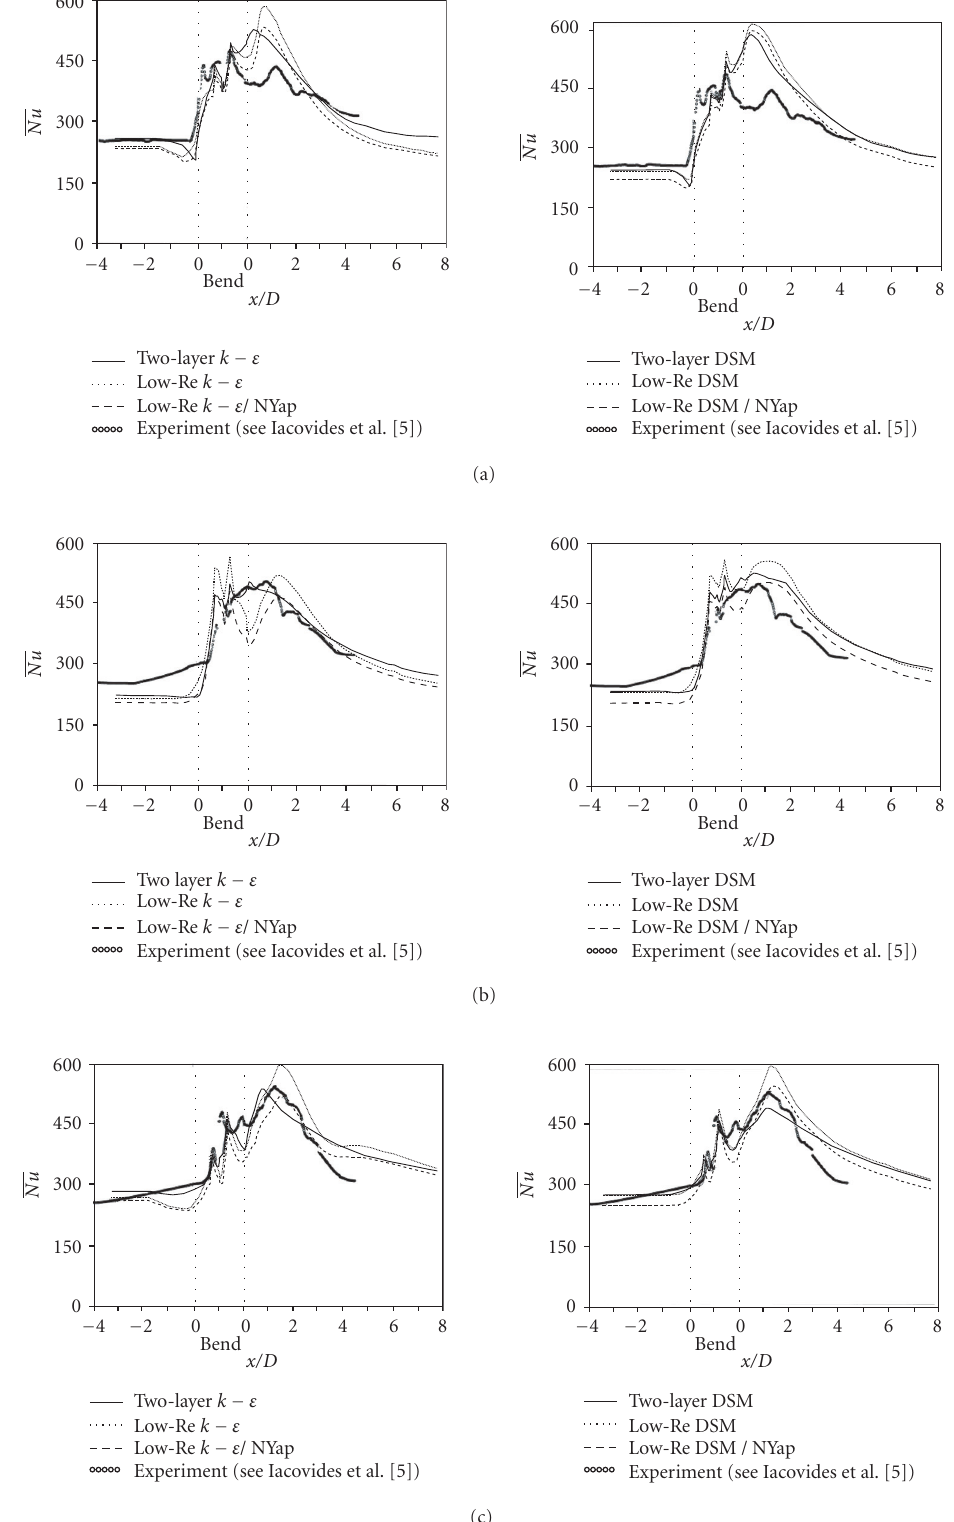
Figure 8: Comparisons of the axial variation of the side-averaged Nusselt number along the flat wall for the stationary and rotating cases. Re = 36000, Pr = 5 . 9, and Ro = 0 . 2. (a) The leading side, (b) the stationary case, and (c) the trailing